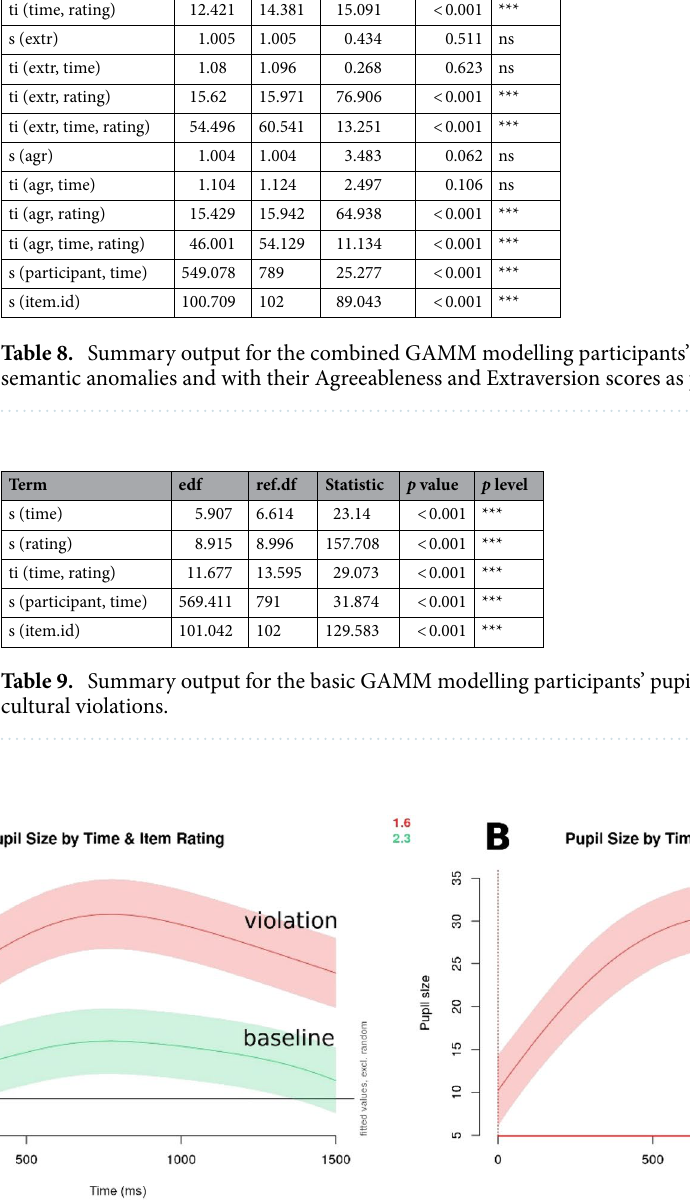
Figure 5. Visualizations of pupil size by item rating over time (in ms since target word onset). Panel A shows baseline (green/lower curve) vs. socio-cultural violation condition (red/upper curve), and Panel B visualizes the difference between the two, with the red line on the x-axis (below the plot) highlighting the time frame where the difference in pupil size between the baseline and error conditions is significantly different. The shaded areas denote a 95% confidence